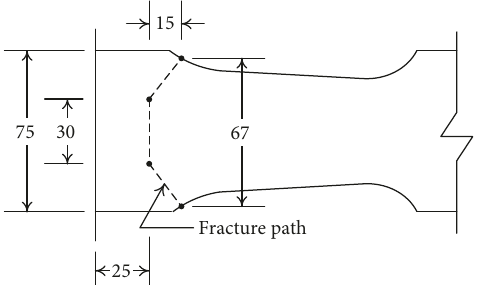
Figure 23: Observed flange fracture path of specimen PW-NB (unit: